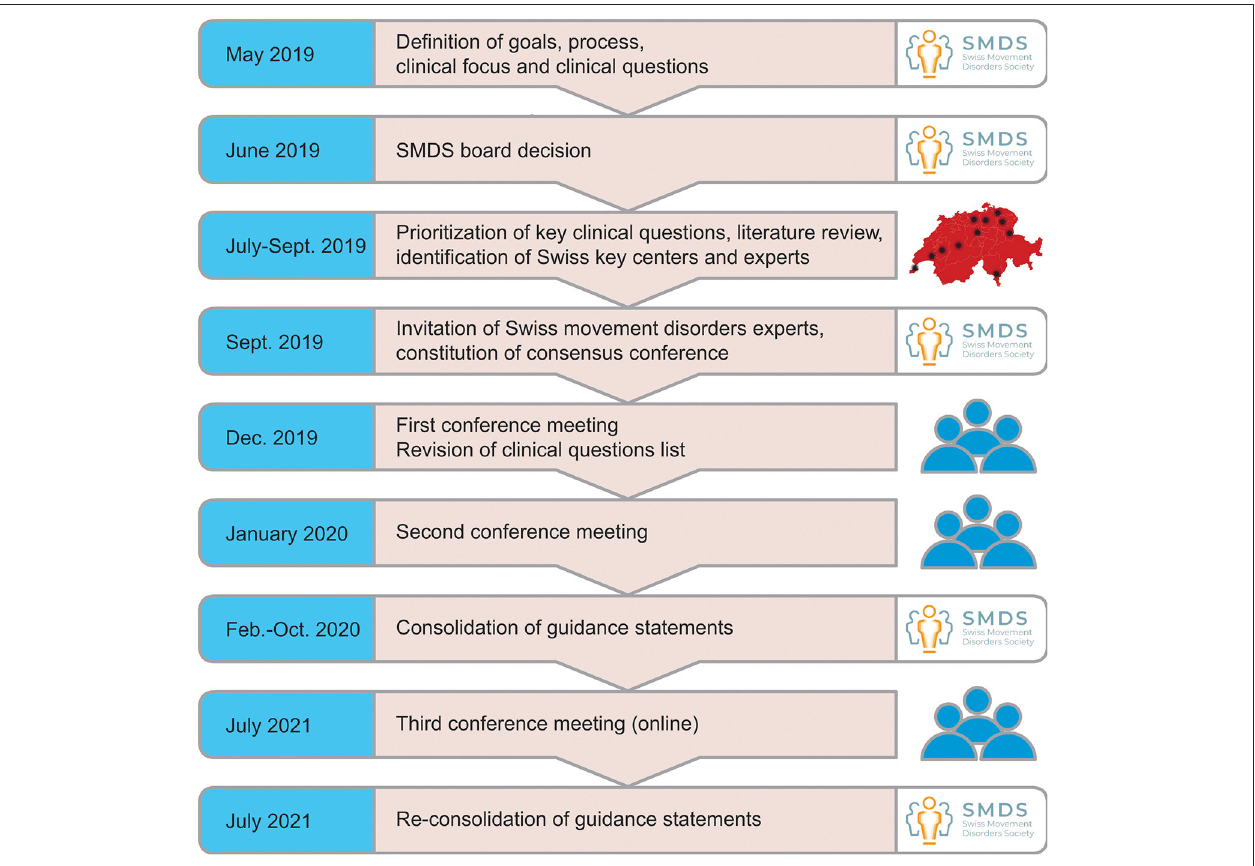
FIGURE 3 | Overview over the process used by the Swiss MRgHiFUS Working Group for definition of topics, consolidation of an expert group and developing consensus on MRgHiFUS treatment in